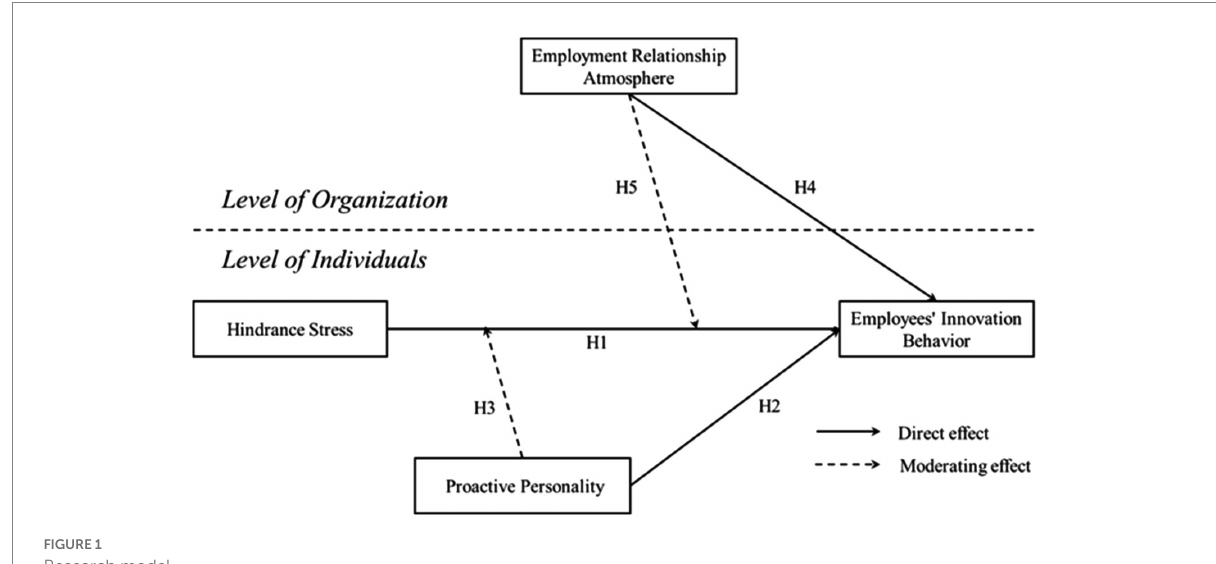
FIGURE 1 Research